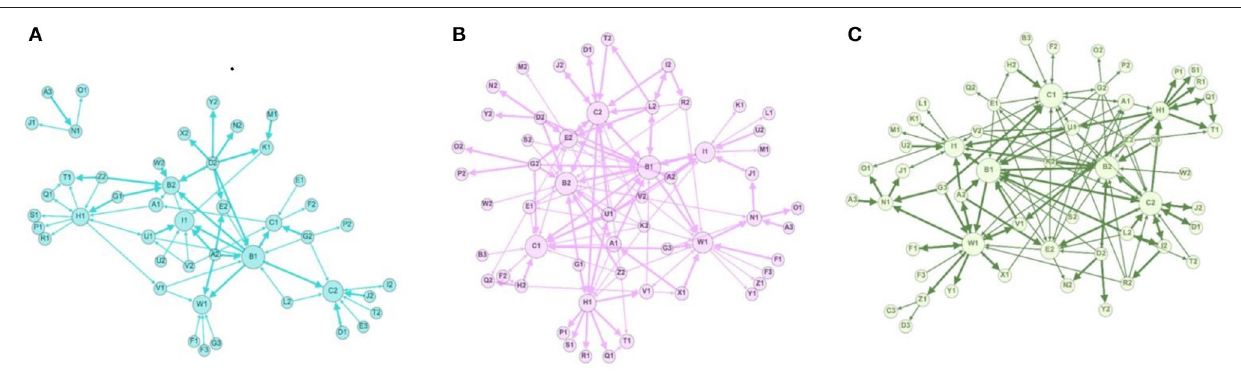
Weighted assortativity